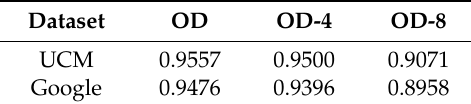
Table 7. Sensitivity analysis in relation to the spatial resolution.